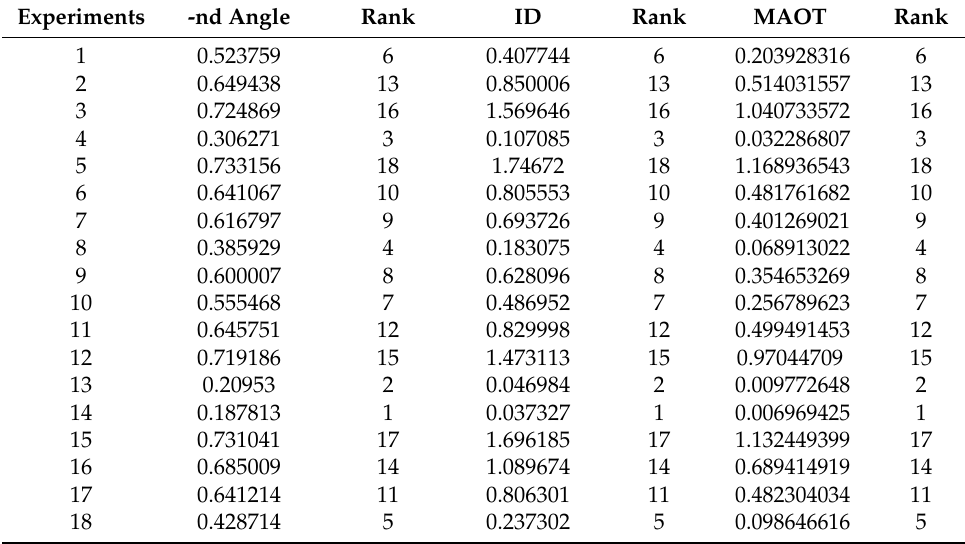
Table 4. Closeness of -nD angle, MAOT, and